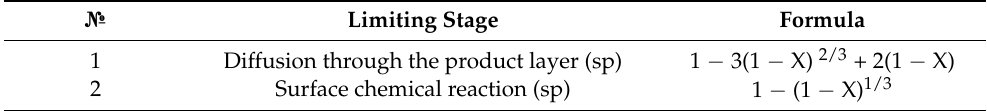
Table 3. Typical SCM kinetic equations applied for systems with spherical particles. № Limiting